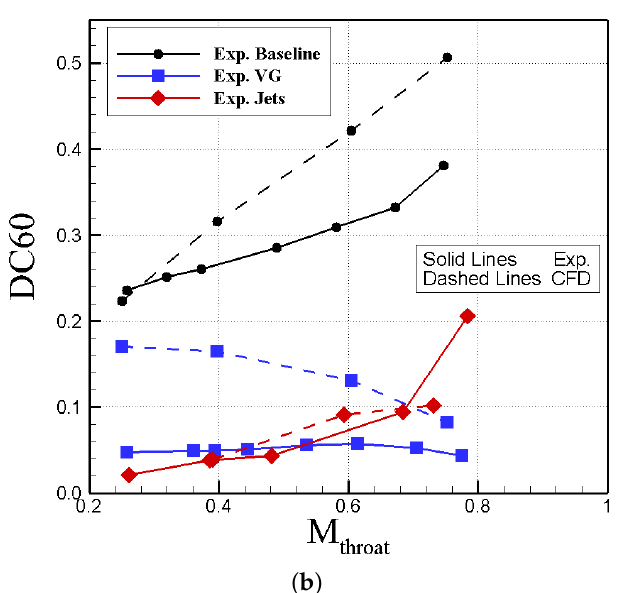
Figure 17. Validation of CFD data. USAFA grids and SARC-DDES turbulence models were used. CFD data are time-averaged from 2 to 2.5 s of simulation time. ( a ) Pressure Recovery; ( b )